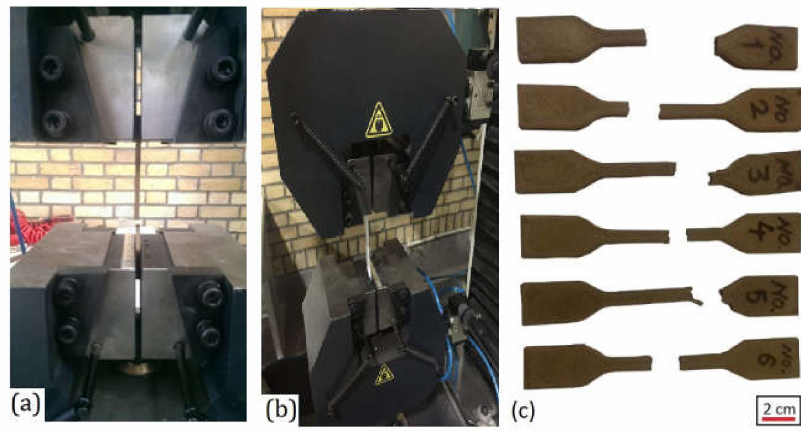
Figure 3. ( a ) Brittle fracture of the specimen (sample #12 Br-PLA), ( b ) Brittle fracture of the optimum PLA specimen, ( c ) fracture of #1 to #6